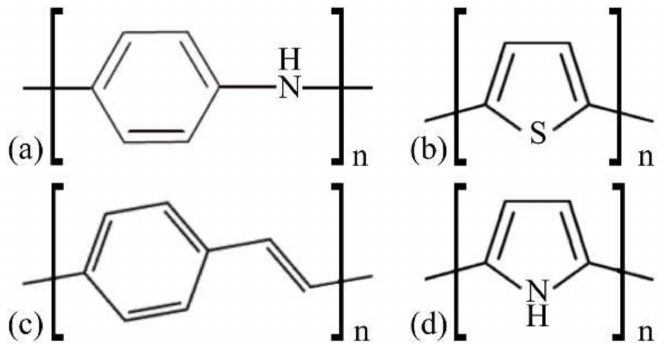
Figure 1. Basic structures of the polymeric materials. ( a ) polyaniline (PANI), ( b ) polythiophene (PT), ( c ) poly ( p -phenylene vinylene) (PPV), and ( d ) polypyrrole